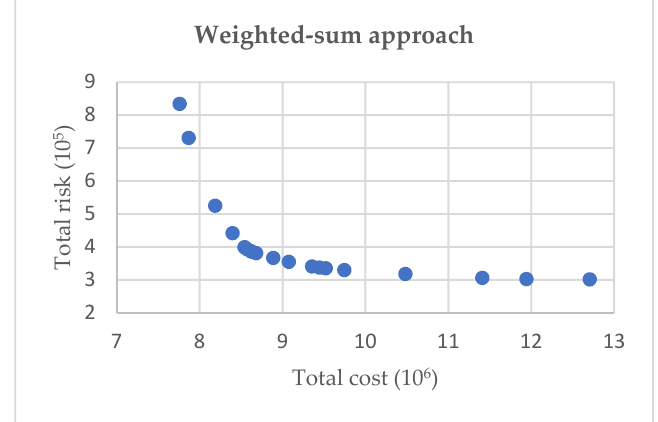
Figure 7. Solutions in weighted-sum approach.